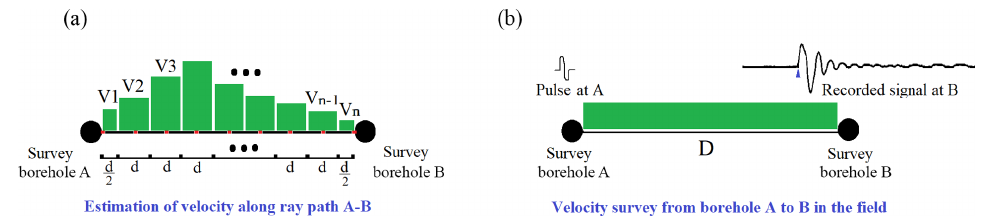
Figure 11. (a) Schematic concept of calculating a ray path velocity from approximated velocities at grid points (Marked with the red squares) located on the ray path. (b) A conceptual velocity survey performed along ray path A–B in the field.